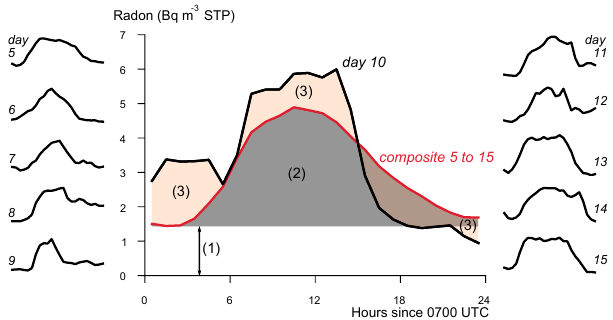
Figure 2. The definition of diagnostic quantities computed after ranking days by their contribution to the radon diurnal composite, termed the anabatic rank. Diagnostics for the i th day, day 10 in this example, are computed from the i th day radon concentration and the composite of days ranked from i − 5 to i + 5. These are: (1) baseline, the minimum of the composite; (2) anabatic, the mean of the composite; and (3) non-anabatic, the mean of the i th day minus the mean of the composite.